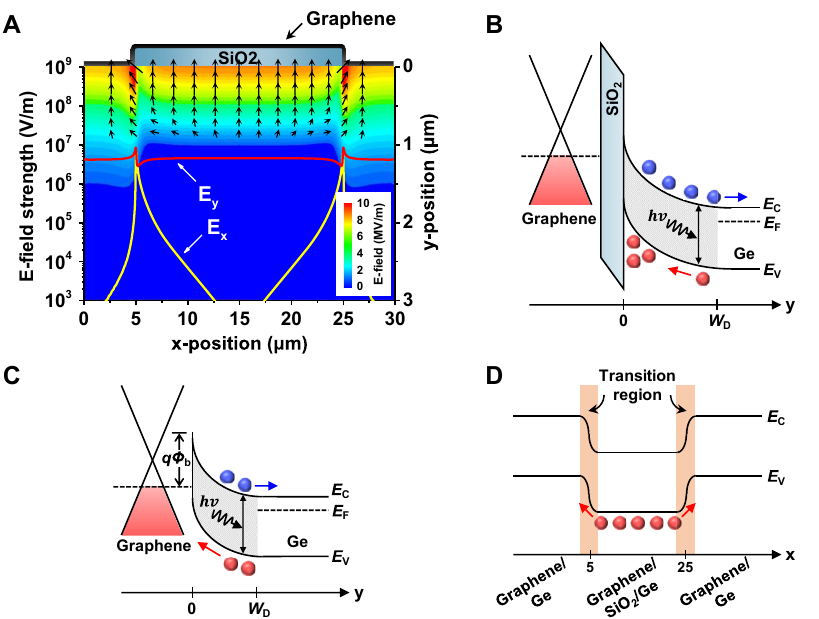
Figure 5: (A) Two-dimensional numerical simulation of the electric field between graphene/Ge and graphene/SiO 2 /Ge region under reverse bias condition ( V D = 4 V). Line pro fi les exhibit the x - and y -components of the electric fi eld ( E x and E y ) 10 nm below the Ge surface along the x - direction. Black arrow: the electric fi eld strength and direction in the Ge substrate. Schematic energy band diagrams of (B) the edge of the graphene/SiO 2 /Ge region and (C) the middle of the graphene/Ge Schottky junction along the y -direction. (D) Lateral band diagram along the Ge surface. Blue and red circle: photogenerated electron and hole in Ge, respectively. Here, Φ b , E C , E V , E F , and W D represent the Schottky barrier height, conduction band edge, valence band edge, Fermi level, and depletion width,